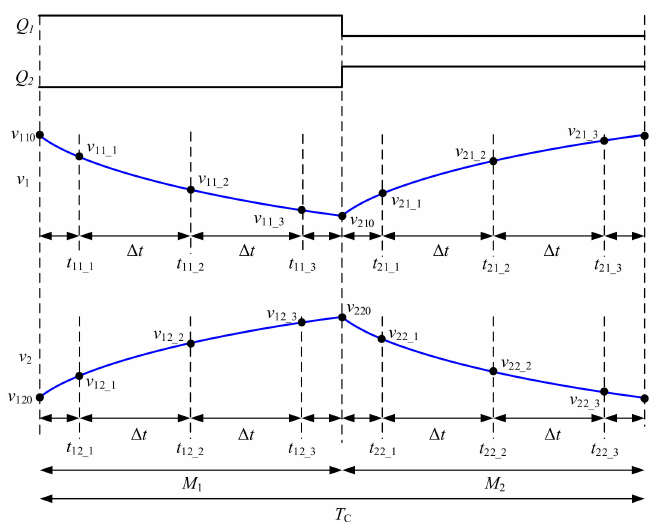
Figure 4. Proposed three-point climbing